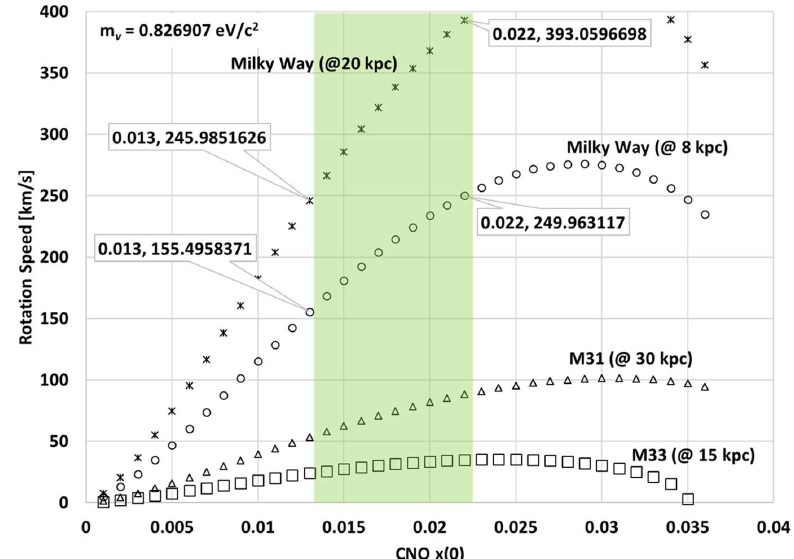
Figure 9. Plots potential local group spiral galactic speed solutions ( y -axis) for a CNO for a degenerate neutrino mass of 0.826907 eV/c 2 against various central boundary condition values for the Fermi momentum ratio ( x -axis). Table 9. Local Group CNO-induced approximate galactic rotational speeds for the degenerate neutrino masses determined from the weak lensing data fits.